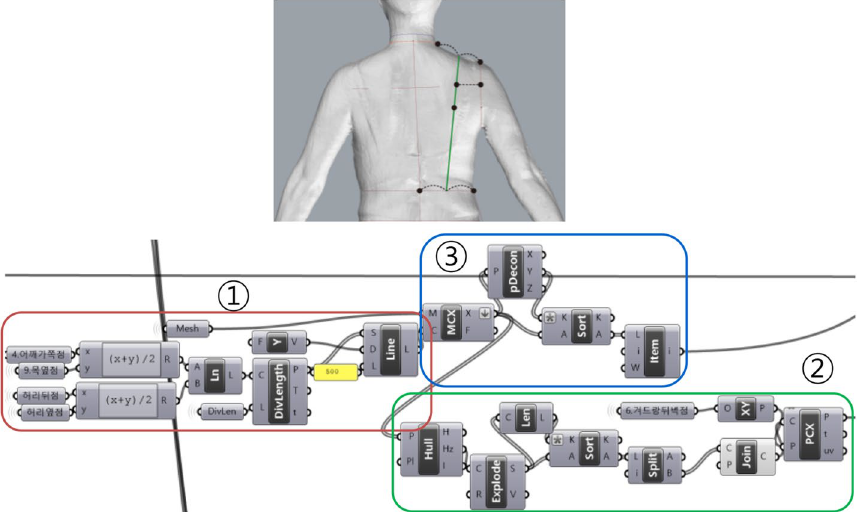
Fig. 13 Scapular point and protrusion point setting process